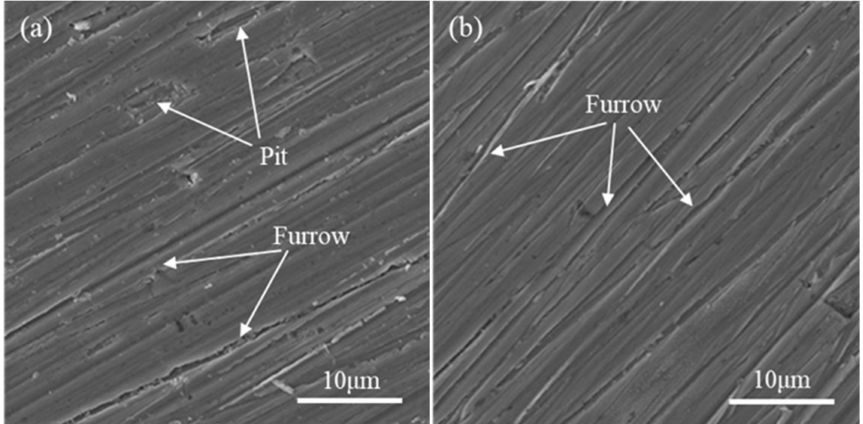
Figure 18. Wear scar morphology: ( a ) substrate and ( b )